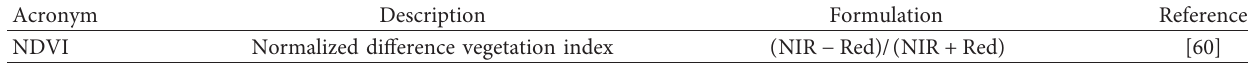
Table 2: Derivation of normalized difference vegetation index (NDVI).